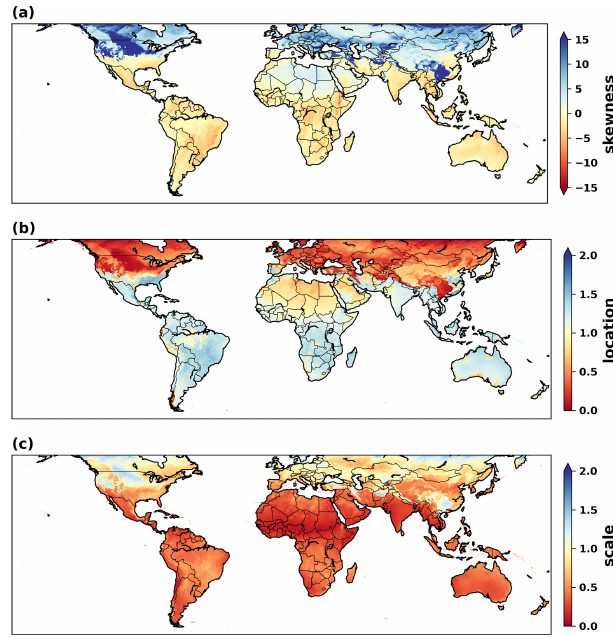
Figure 3. The parameters representing the noise ratio (a) skewness, (b) location, and (c) scale for the month of January over the spatial domain of the stoPET